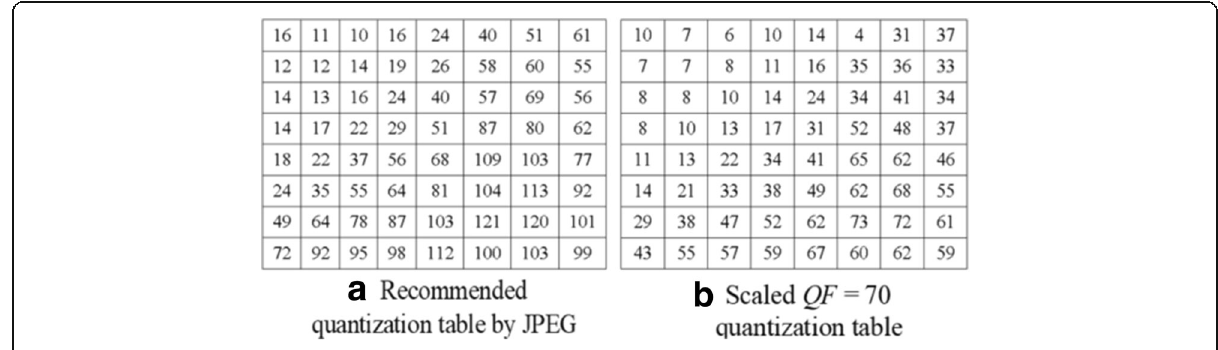
Fig. 1 Block diagram of the legacy JPEG compression